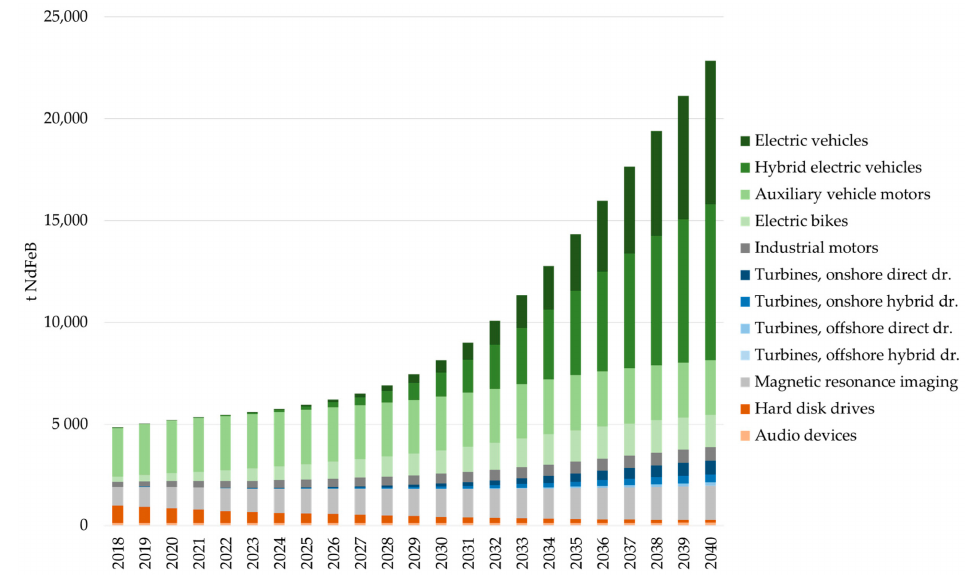
Figure 2. Potential return flows by application in tons of NdFeB. Reprinted from Ref. [60].